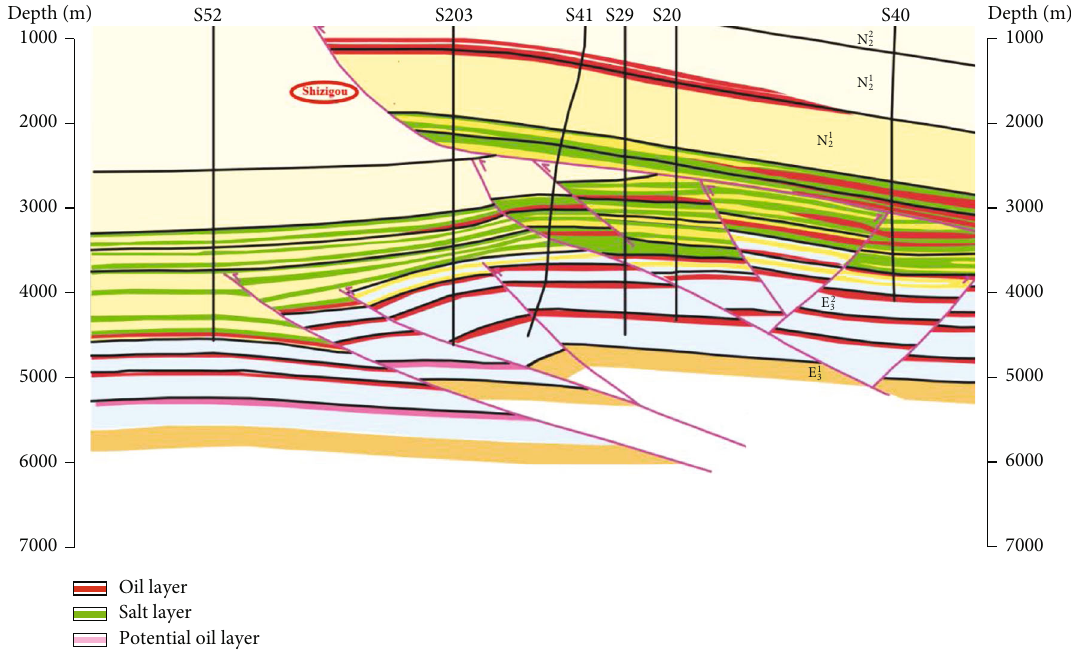
Figure 2: Geologic pro fi le of the Yingxi deep